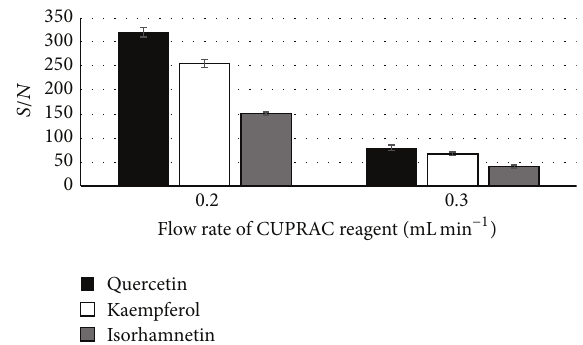
Figure 2: Dependence of peak height-to-baseline noise ratio (𝑆/𝑁) on CUPRAC solution flow rate. The following standards were used: quercetin, 0.074 mg mL −1 ; kaempferol, 0.084 mgmL −1 ;